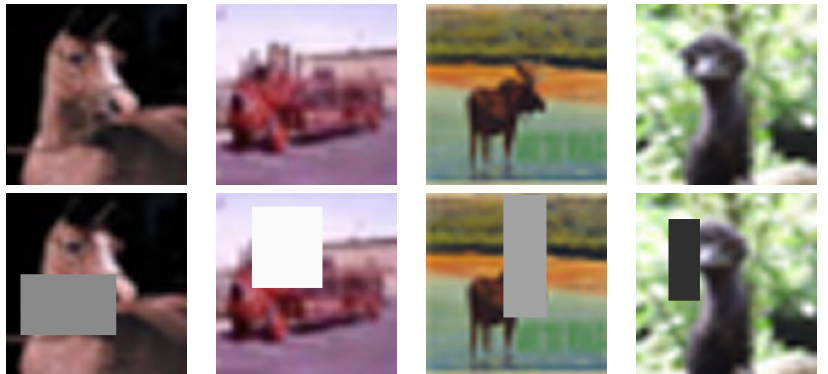
Figure 11. Data augmentation by the random erasing technique. The first and second rows represent the given images (from CIFAR-10) and the images after random erasing,